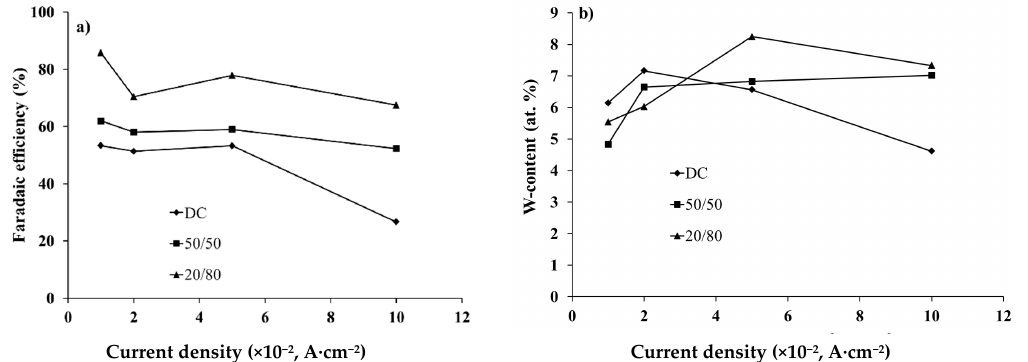
Figure 3. Faradaic efficiency ( а ), and W content ( b ) in Ni–W alloys versus the cathode current density in the DC and the pulse current modes with the different duty cycles (50% and 80%). The pH of the electrolytes is 9.5. For both modes a weak dependence of W content on the cathode current density was observed (Figure 2b). In comparison with the DC mode, in the pulse current mode a certain increase in W content occurs in alloy. At the same time, a decrease in the duty cycle leads to an increase in W content, which can be explained by the restoration of the concentration of W-containing ligand ions in the near-cathode layer due to their diffusion during the pauses between pulses.